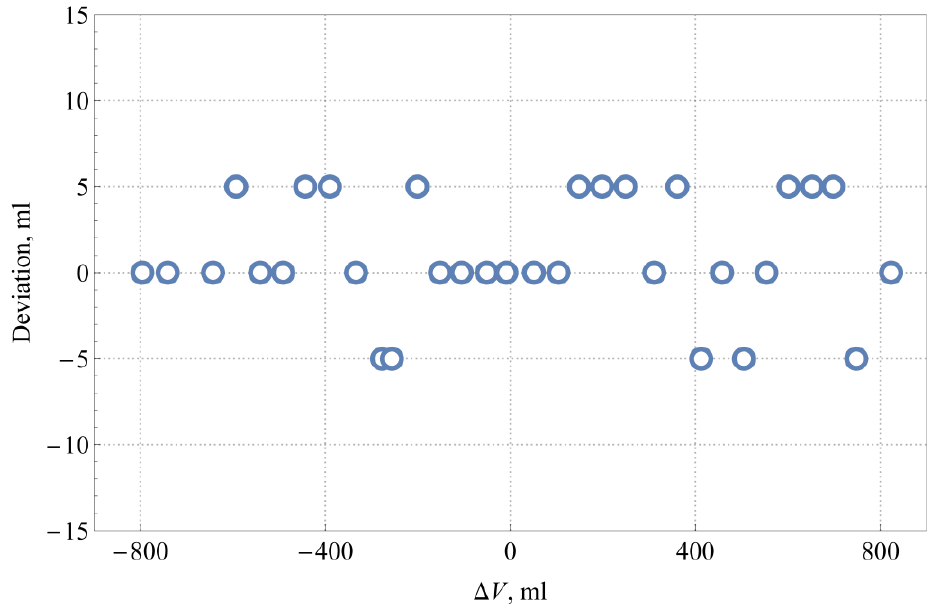
Figure 10. Deviation between the operators’ readings for different liquid levels.